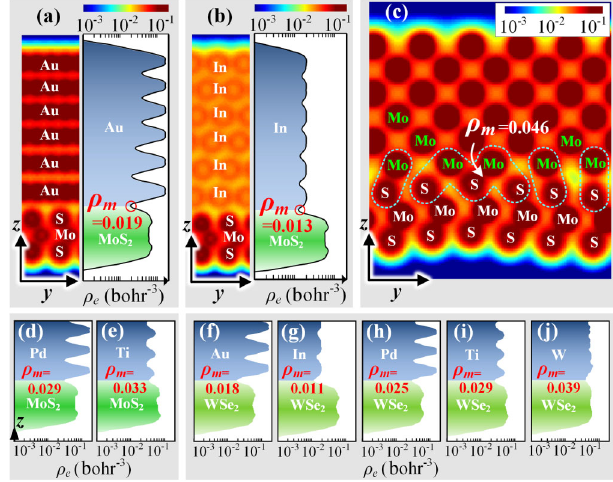
FIG. 15. Valence electron densities (bohr − 3 ) of metal-mTMD top contacts: (a) Au-MoS 2 , (b) In-MoS 2 , (c) Mo-MoS 2 , (d) Pd-MoS 2 , (e)Ti-MoS 2 ,(f)Au-WSe 2 ,(g)In-WSe 2 ,(h)Pd-WSe 2 ,(i)Ti-WSe 2 , (j) W-WSe 2 . Panel (c) and the left-hand contours in(a) and (b) show averagedensityalong x projectedonthe y - z plane.Panels(d) – (j)and the right-hand plots in (a) and (b) show average electron density value in the x - y planes normal to the z axis ( ρ indicates the minimum x - y plane average electron density at each interface (in units of bohr − 3 ).